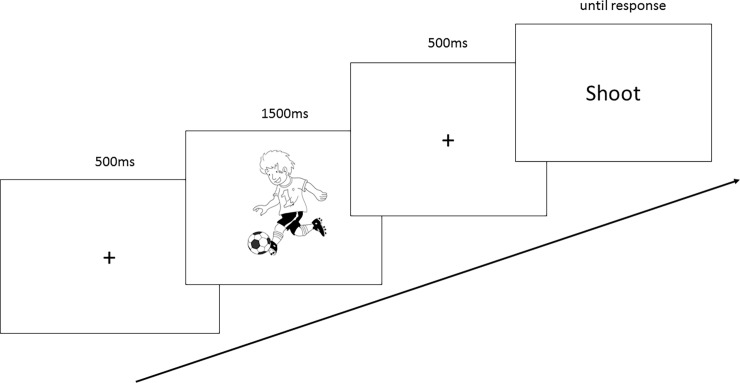
Procedure of the experiment task.The fixation cross, the prime picture as well as the verb stimulus were centered on the screen. The arrow represents the sequence of one trial. The image was one of the ten images extracted from Clic-image 2.0 selected in the French database Clic images 2.0 which proposes royalty-free illustrations (see Clic-Image2-0 –Réseau Canopé http://www.cndp.fr/crdp-dijon/clic-images/).